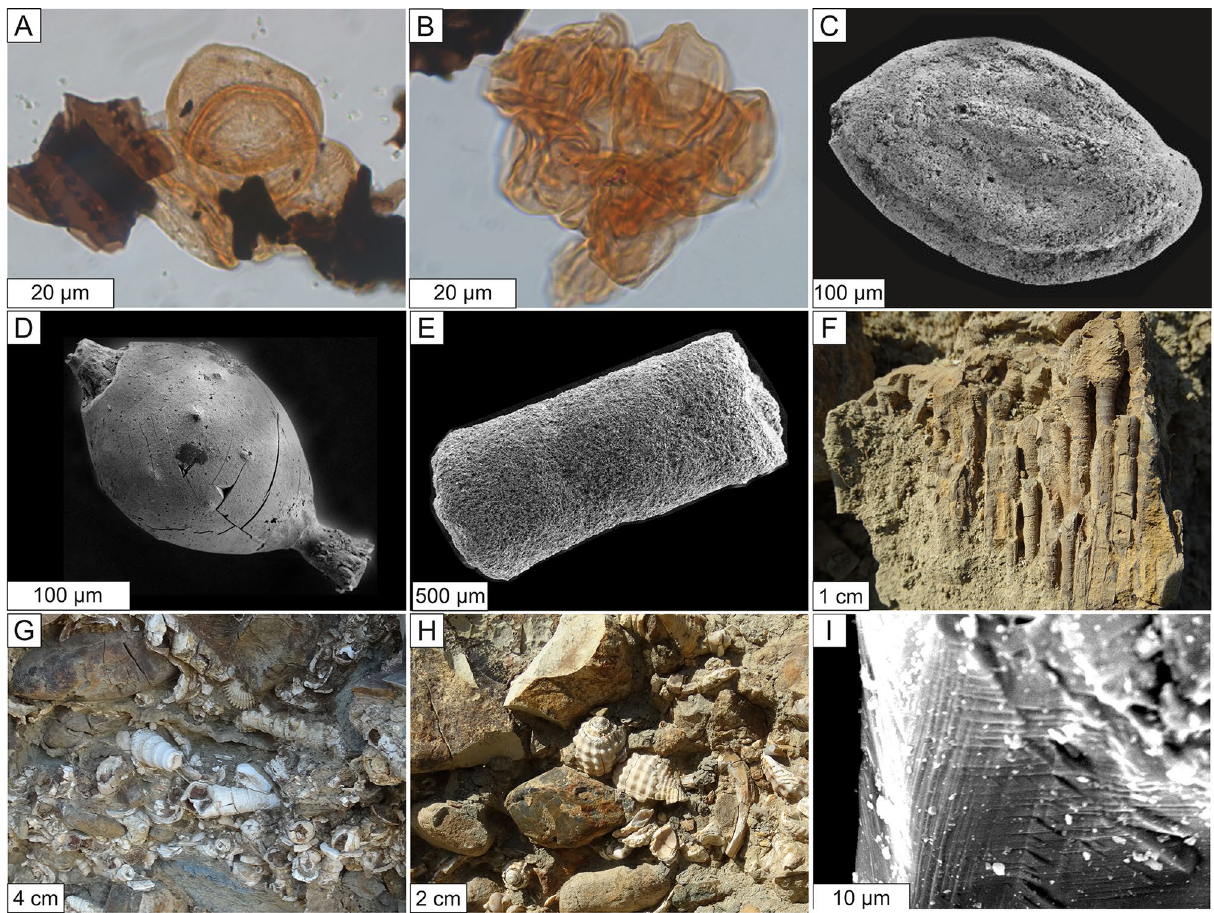
Figure 4. ( A ) Classopollis sp. tetrad, slide coordinates C44-4 (sample LOG-01–002); ( B ) Cluster of fungal spores, slide coordinates C43-1 (sample LOG-01 MWD4); ( C ) Miliolid (sample LOG-05–03); ( D ) decalcified Lagenid, (sample LOG-05–21); ( E ) Bathysiphon sp. (sample MWD-18); F) Isopora sp. corals; ( G ) Turritella webbi gastropods, bivalve shells, pebbles, and cobbles; ( H ) Retipirula crassitesta gastropods; ( I ) shocked quartz crystal (sample